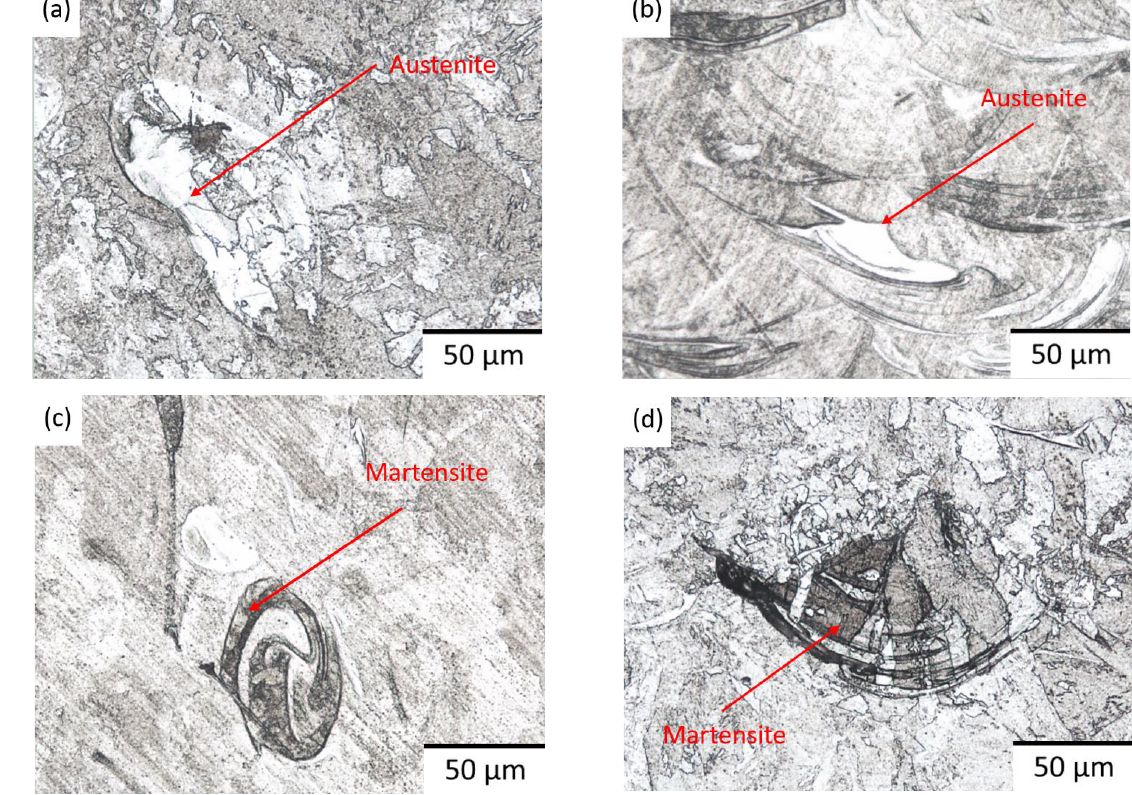
Figure 11. Identification of ( a , b ) austenite phase in build direction and transverse direction and ( c , d ) martensite phase in build and transverse direction.